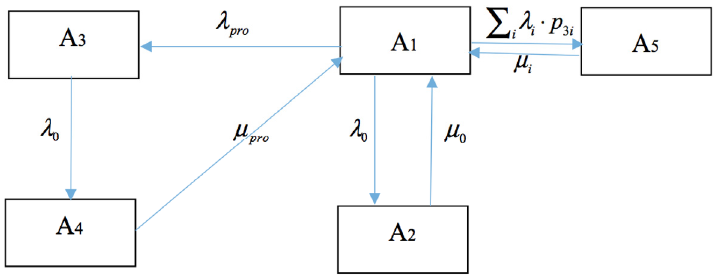
Figure 7. The completed multi-state Markov chain model of transmission lines incorporating protection function